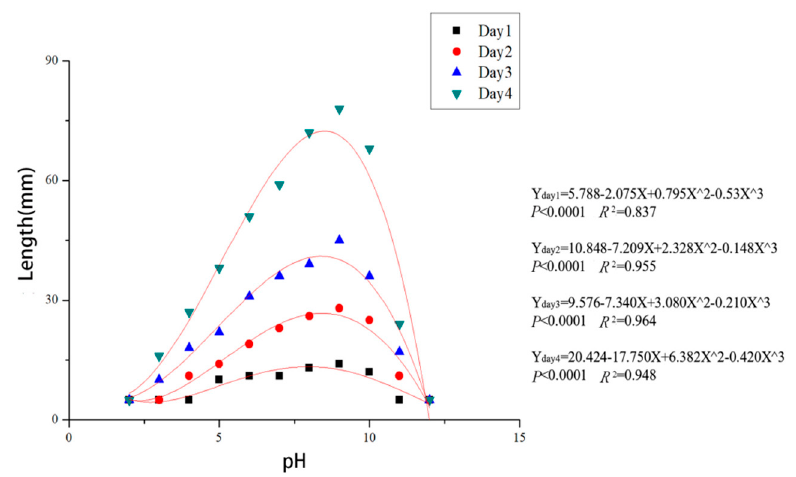
Figure 6. Regression curves and equations for mycelial growth of Cytospora haidianensis after incubation for 24, 48, 72 and 96 h at pH 2.0, 3.0, 4.0, 5.0, 6.0, 7.0, 8.0, 9.0, 10.0, 11.0 and 12.0 on PDA medium (X = pH, Y = growth (colony diameter, mm)). Optimum mycelial growth was estimated to be at pH 8.3.